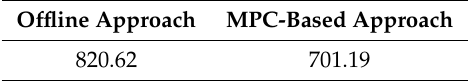
Table 4. Cost function value for each of the results considered.